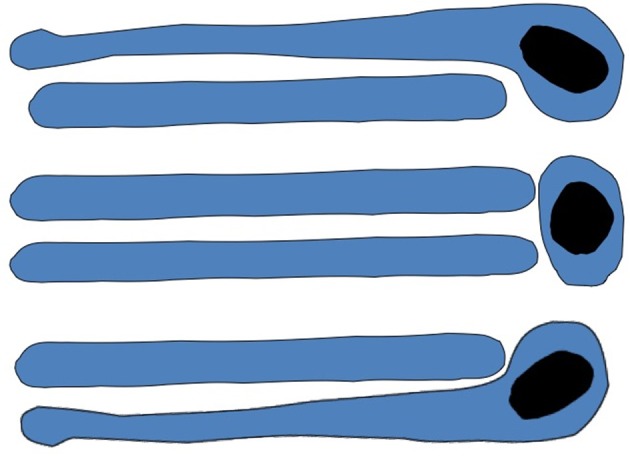
Scheme of megavesicle-based intra-Golgi transport. This hypothesis assumes that completely isolated megavesicle (in the middle of both images) can be found near the Golgi complex.